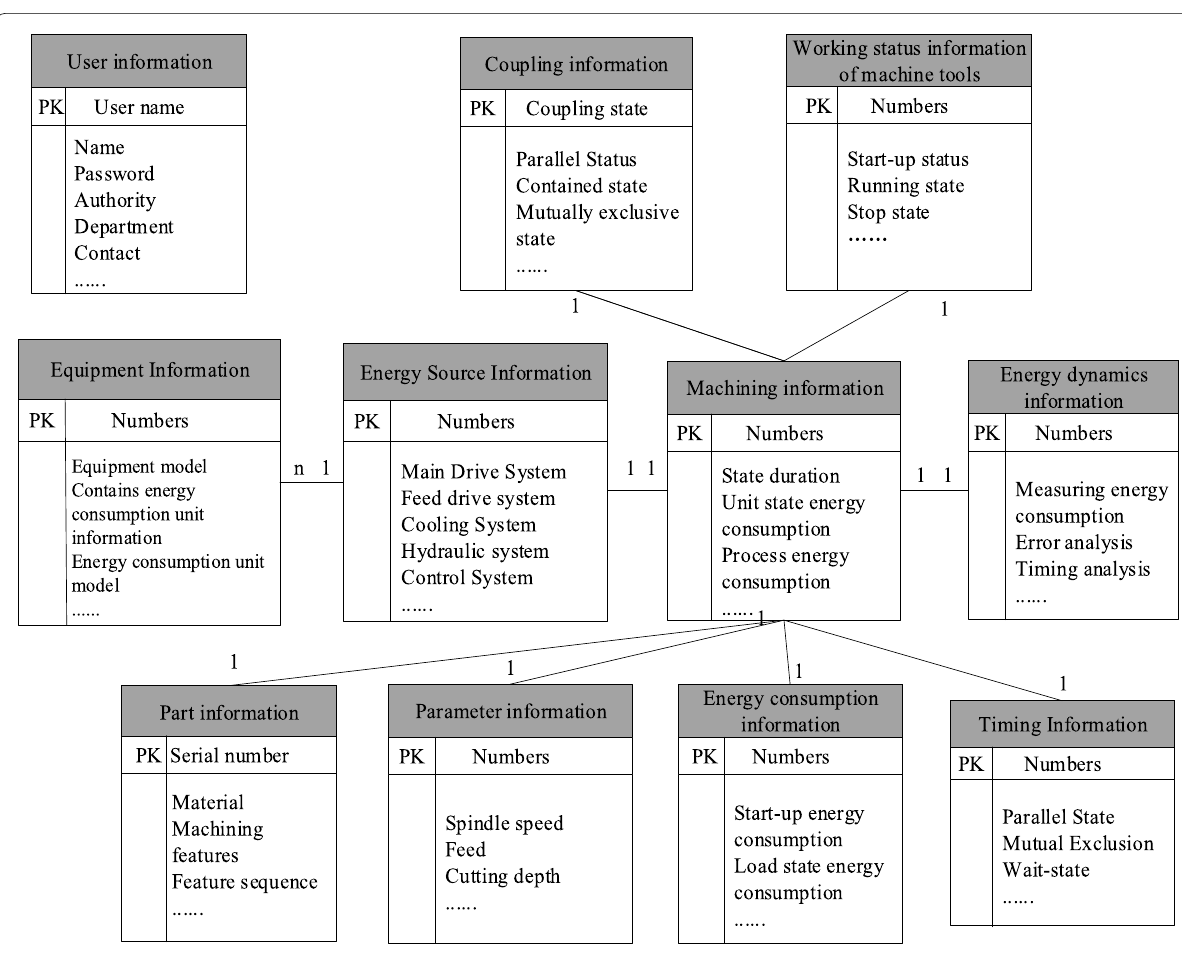
text association symbols add necessary annotations to the model to enhance its